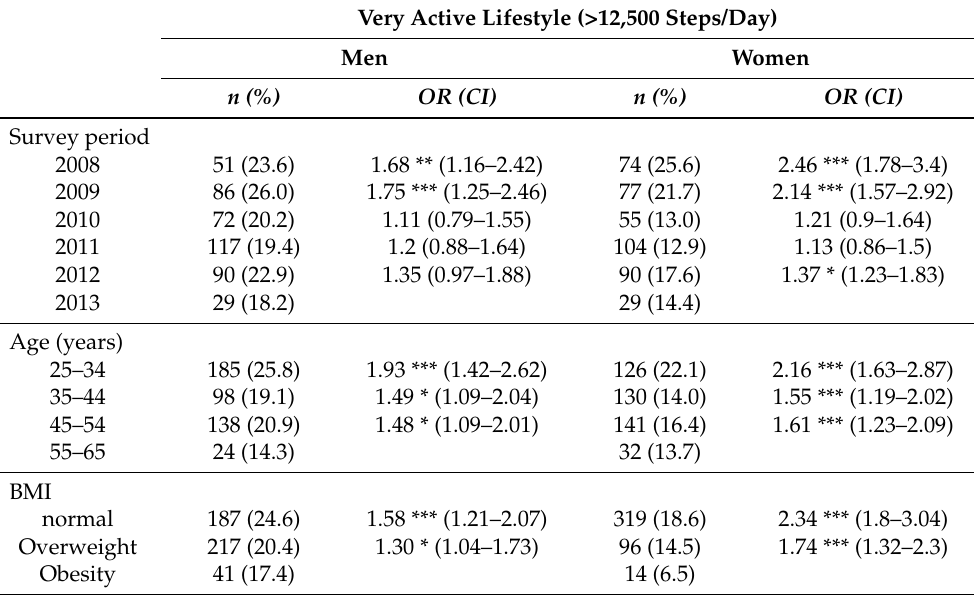
Table 4. Odd ratios (ORs) and 95% confidence intervals (CIs) for step-defined very active lifestyle. Very Active Lifestyle (>12,500 Steps/Day)